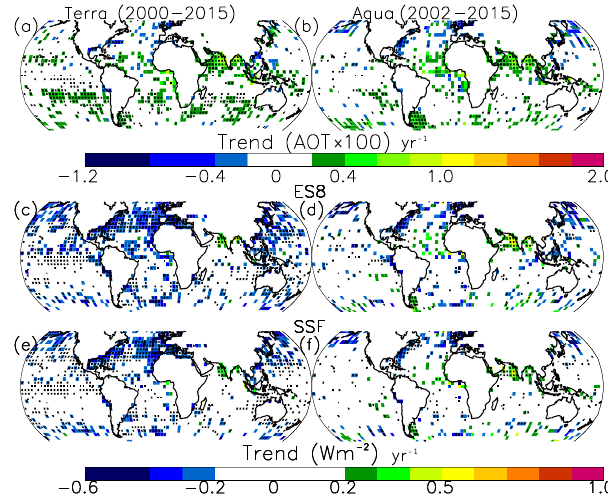
Figure 12. Spatial distribution of gridded AOT trends for (a) 16- year Terra (2000–2015) and (b) 14-year Aqua (2002–2015) for ev- ery 4 ◦ × 4 ◦ (latitude / longitude) bin derived from the collocated MODIS–CERES dataset. AOT trends are constructed using sea- sonally averaged AOTs. (c) Spatial distribution of cloud-free sky CERES ES-8 SW flux trends estimated using the collocated Terra MODIS–CERES data for the study period of 2000–2015. (d) Sim- ilar to (c) , but using the collocated Aqua MODIS–CERES (ES-8) dataset for the study period of 2002–2015. (e–f) Similar to ( c ) and ( d ), but for using CERES SSF data. Grids with statistically signifi- cant AOT/clear-sky SW flux trends at the 95% confidence interval are shown in black